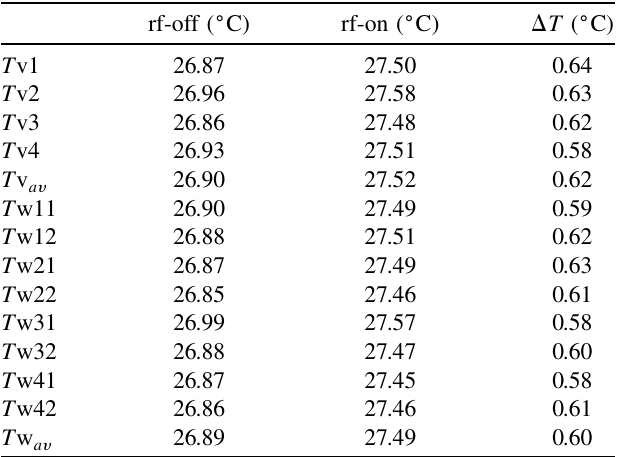
TABLE II. Measured temperature rise of each cooling-water ¼ 330 kW and a duty of 3%. rf-off and rf-on channel with P peak indicate the temperatures at the exit of each channel when rf power is fed and not fed, respectively. (cid:1) T denotes the difference between rf-on and